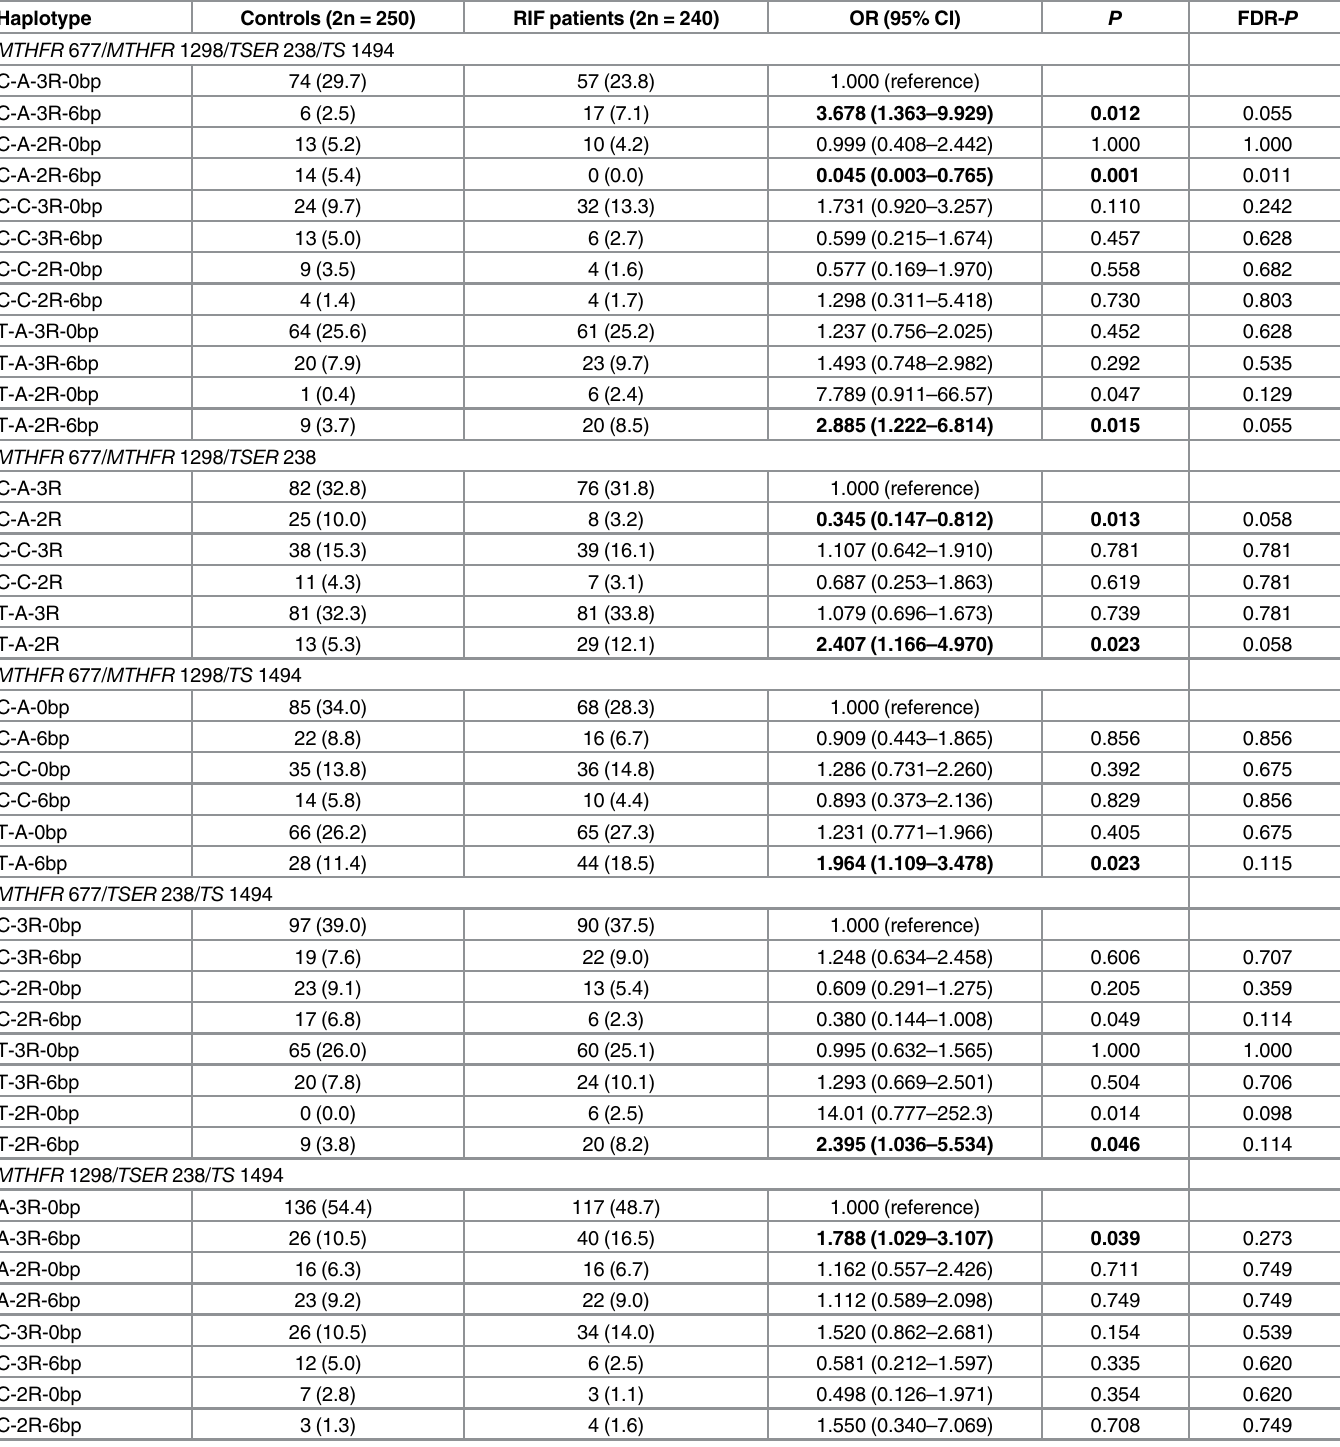
Table 4. Allelic gene-gene interaction of one-carbon metabolism-related gene polymorphisms between controls and RIF